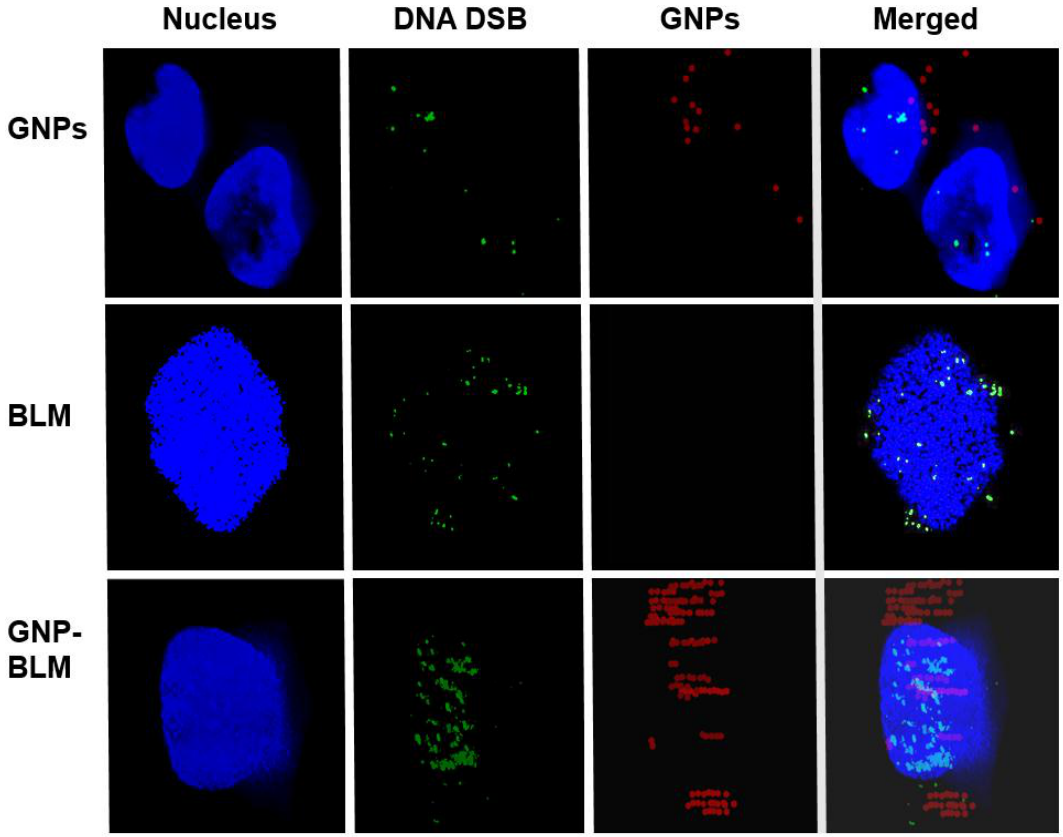
Figure 7. Hyperspectral mapping of GNP distribution and DNA DSBs within cells. Citrate capped GNPs did not enter the nucleus and caused less DNA DSBs ( top panel). Free drugs caused more DNA DSBs ( middle panel). The GNP-BLM complex entered the nucleus and caused more DNA DSBs ( Bottom panel).